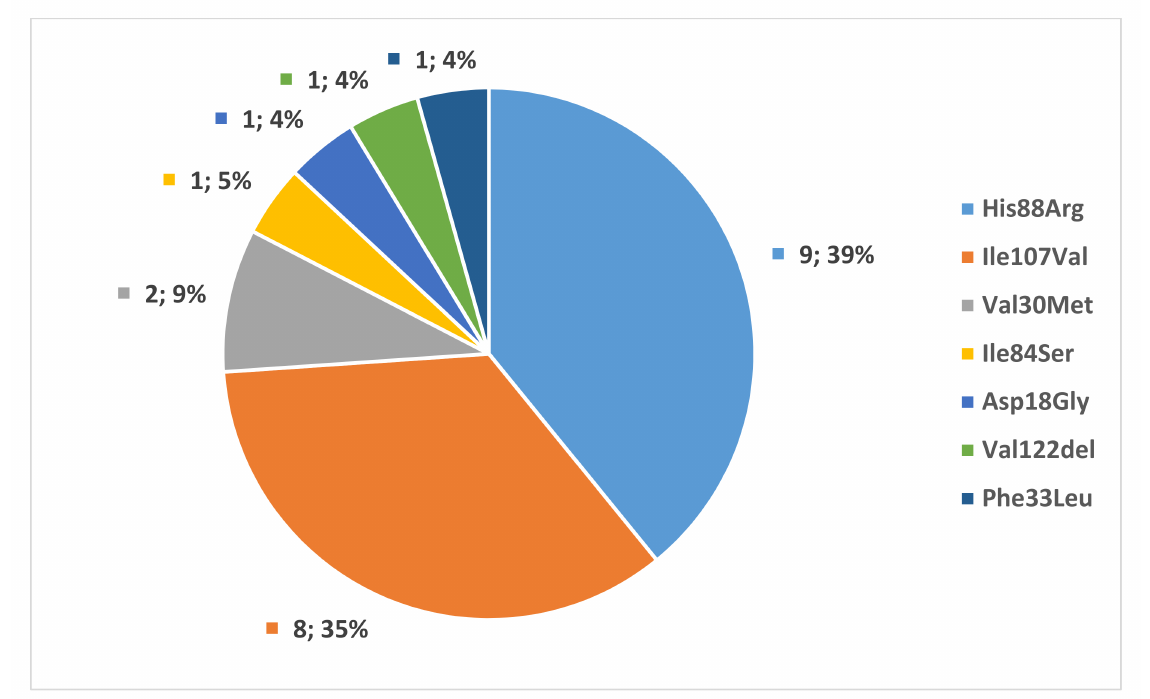
Figure 1. Genetic spectrum of TTR mutations in Hungarian families, expressed in number and percentage of the affected families ( n = 23).